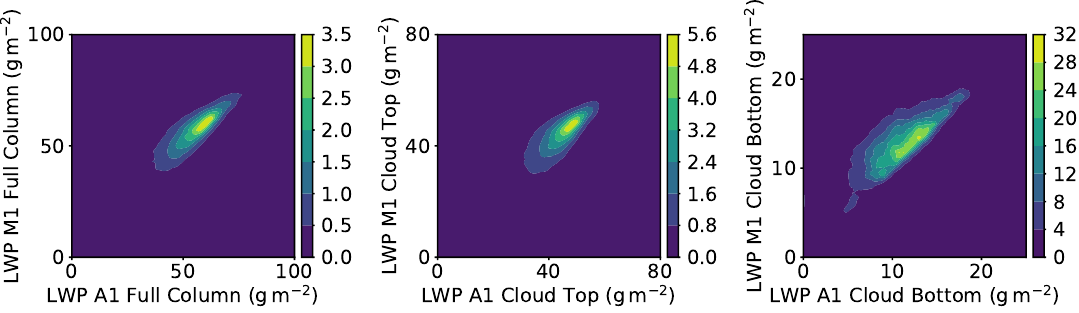
Figure 10. Correlations between LWP distributions between Cases A1 and M1. The contours correspond to the normalized joint two-dimensional histograms of LWP. The legends correspond to probability per g 2 m − 4 × 10 3 . The left panel corresponds to the full-column LWP, upper-half of the cloud is shown in the middle panel, and the lower-half of the cloud is shown in the right